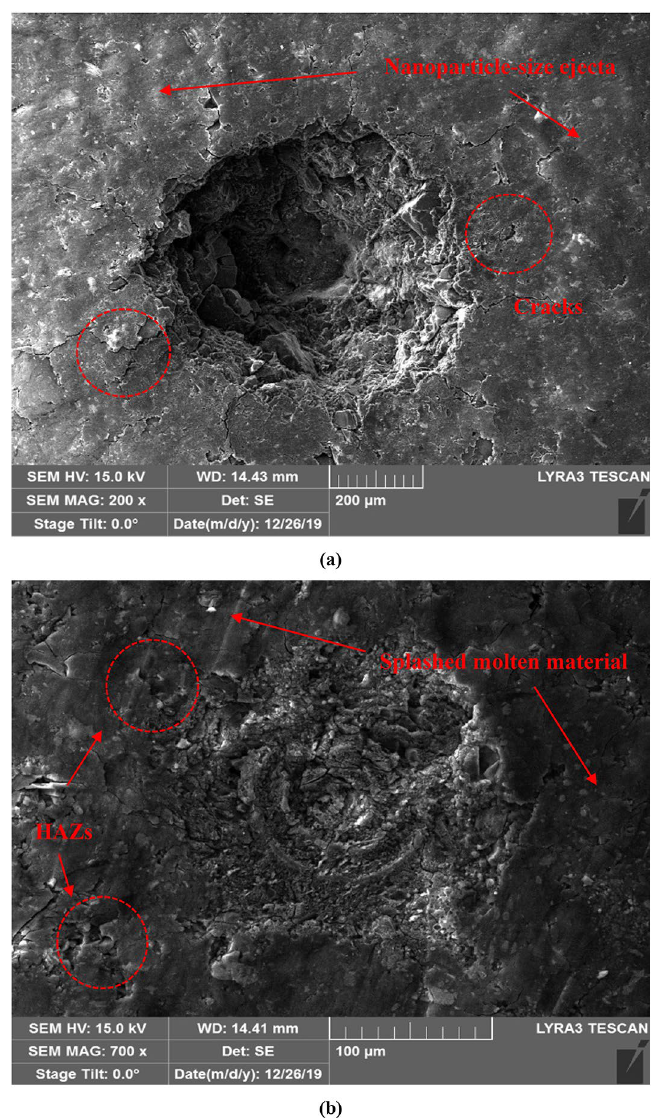
Figure 6. Focused ion beam scanning electron microscopy (FIB-SEM) images of laser ablation craters formed using ( a ) fs-Solstice sytem where: no rim not heat affected zones (HAZs), cracks at the crater’s edge due to strong fs laser hit, and powdery appearance of ejecta are observed; ( b ) ns-Chem system where: rim, HAZs, molten and splashed particles are